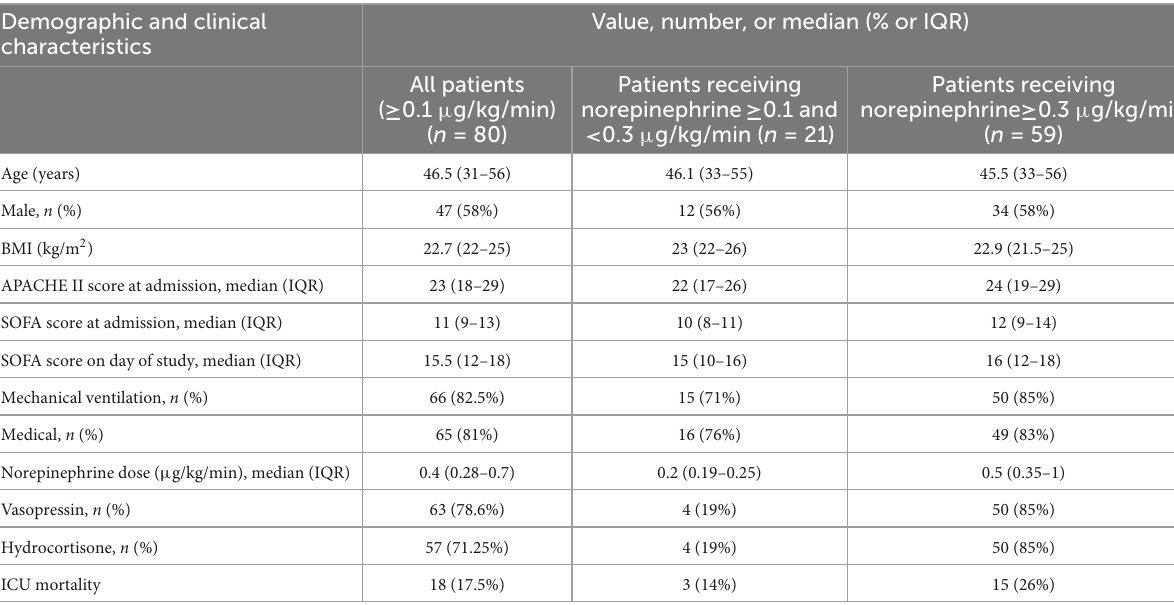
TABLE 1 Demographic and clinical characteristics of patients included in the study ( n =